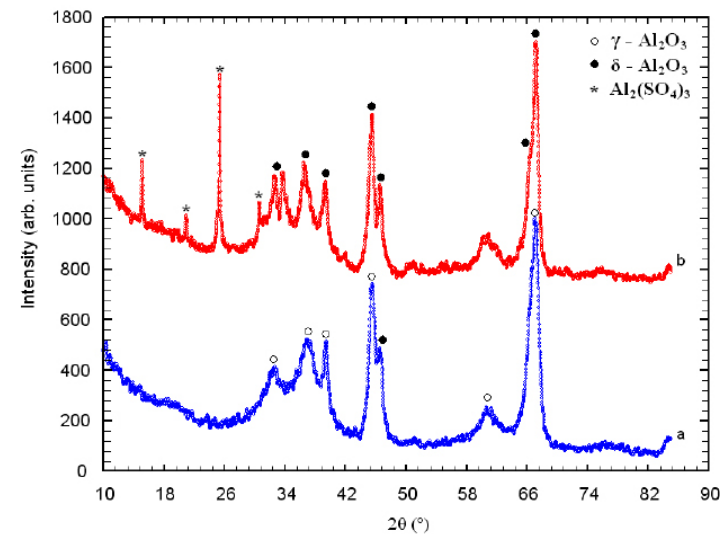
Figure 5. X-ray diffractions patterns of 0.5 wt.% Pd/Al